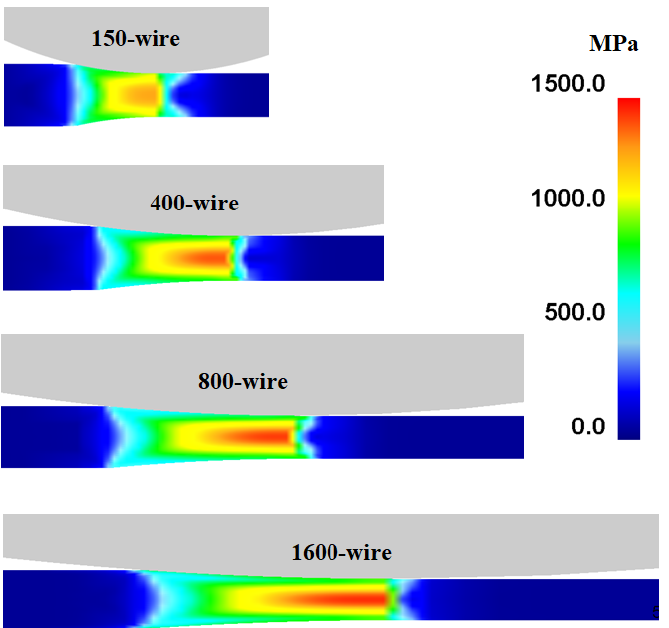
Figure 9. Comparison of the effective stress along the rolling direction of the wire with the roll diameter during wire flat rolling.